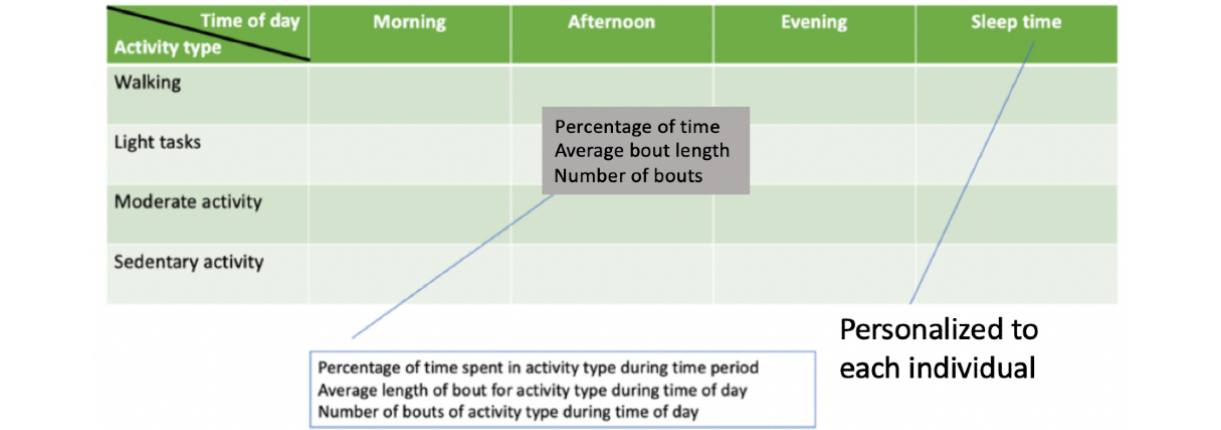
Figure 3. Feature matrix for physical activity bout representation